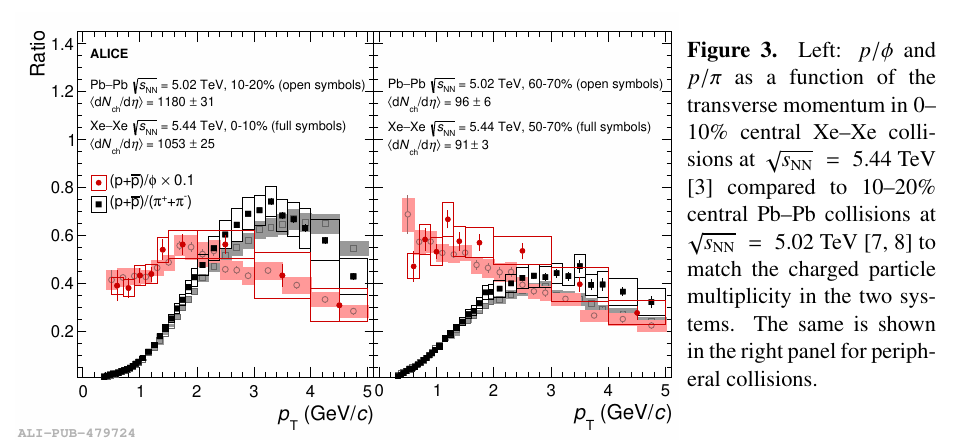
Figure 1. Transverse momentum distributions of π ± , K ± , p , ¯ p and φ as measured in central (left) and peripheral (right) Xe–Xe collisions at √ s NN = 5 . 44 TeV. of two scintillator detectors located in the pseudorapidity region 2 . 8 < η < 5 . 1 (V0A) and